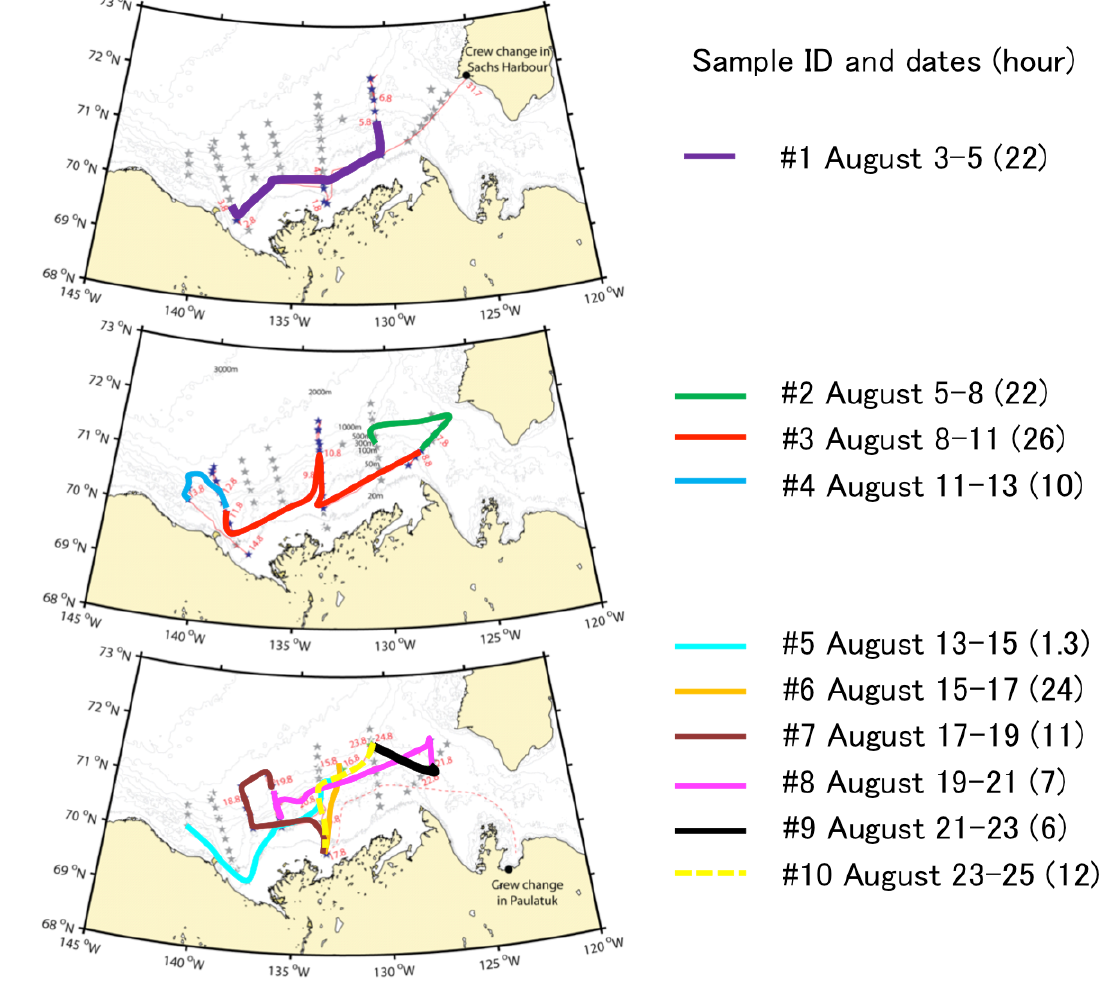
Fig. 1. Map of the western Arctic Ocean and the MALINA cruise tracks for aerosol sampling. The sampling hours are given in parenthesis.